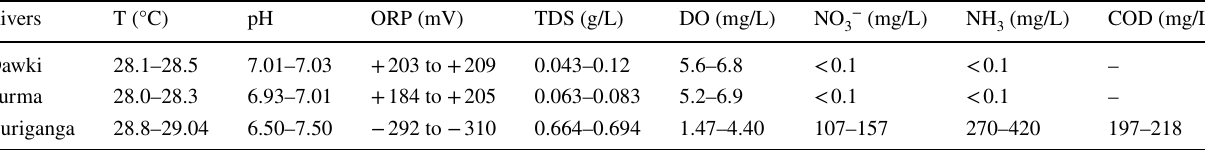
Table 1 In situ determined physical and chemical parameters of river waters Rivers